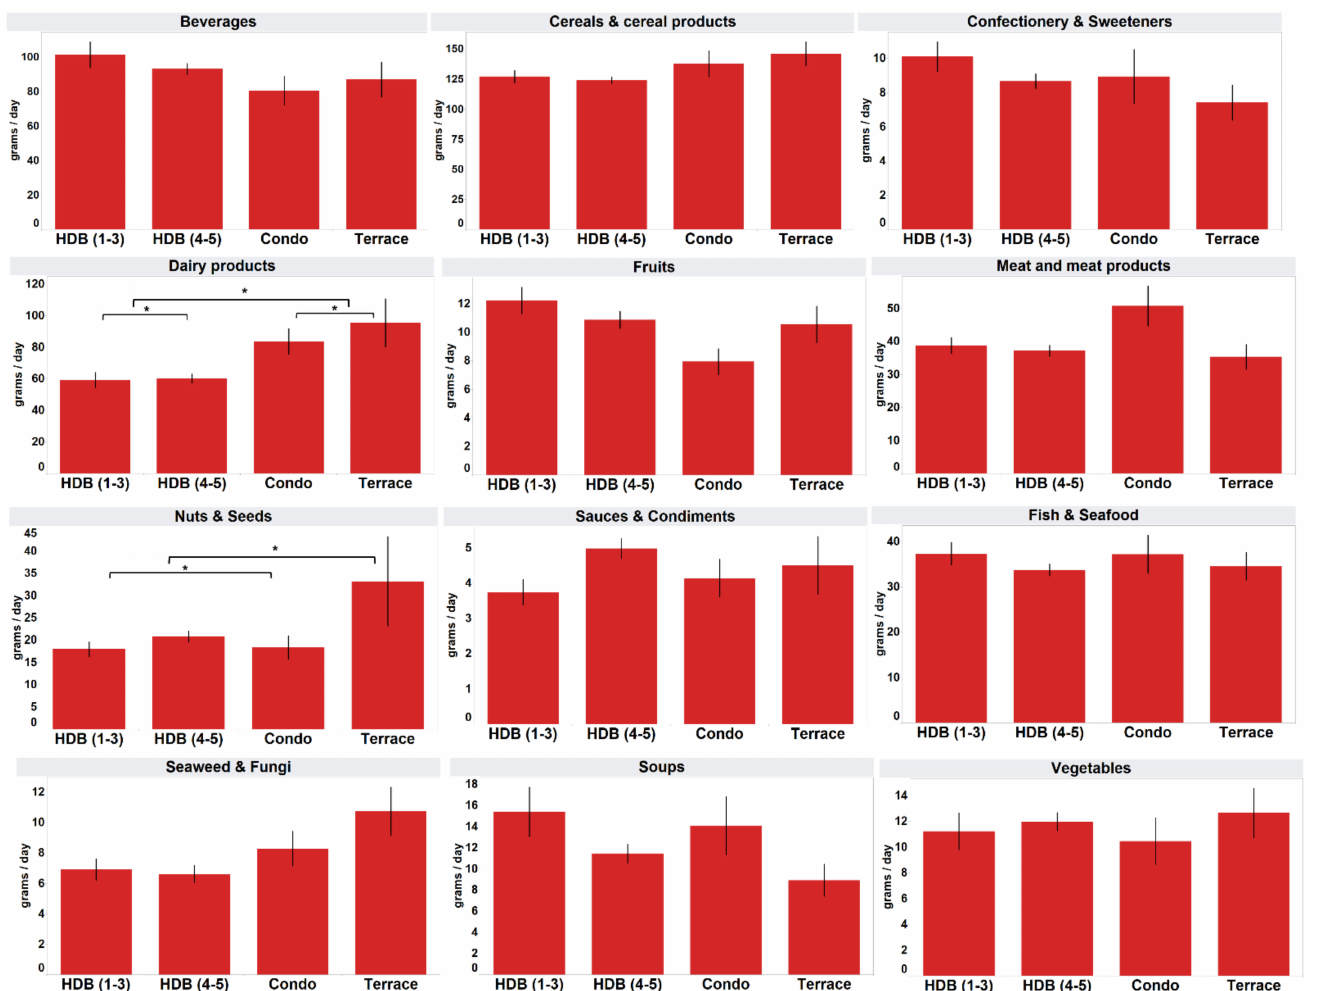
Figure 4. Mean daily intake of consumers analysed by housing type. * Mean values were significantly different as determined by ANOVA with Tukey’s HSD test for multiple comparisons ( p < 0.05). HDB refers to public housing, with the number of rooms in the apartment reported in